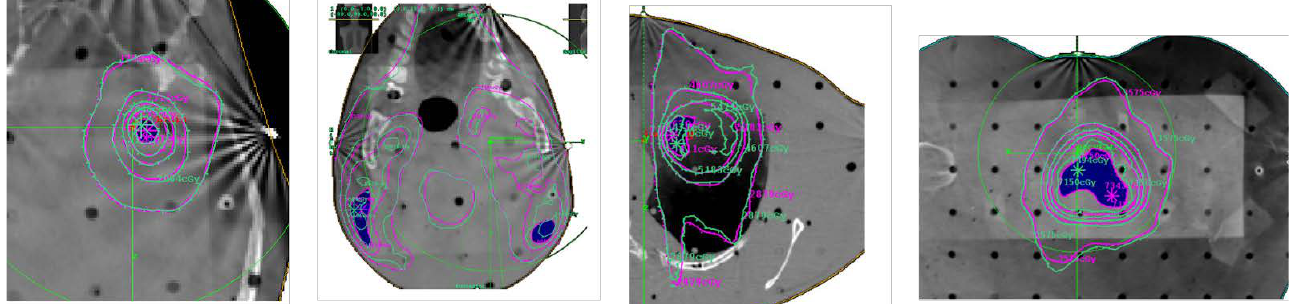
Figure 8. Comparison of computed dose distribution for the VMAT plans: green lines are the doses computed by the treatment planning system; pink lines are the doses reconstructed by the Dosimetry check with the Collapsed cone convolution algorithm. Isodoses curves displayed are the 100%, 95%, 90%, 80% and 50% of the prescribed dose.